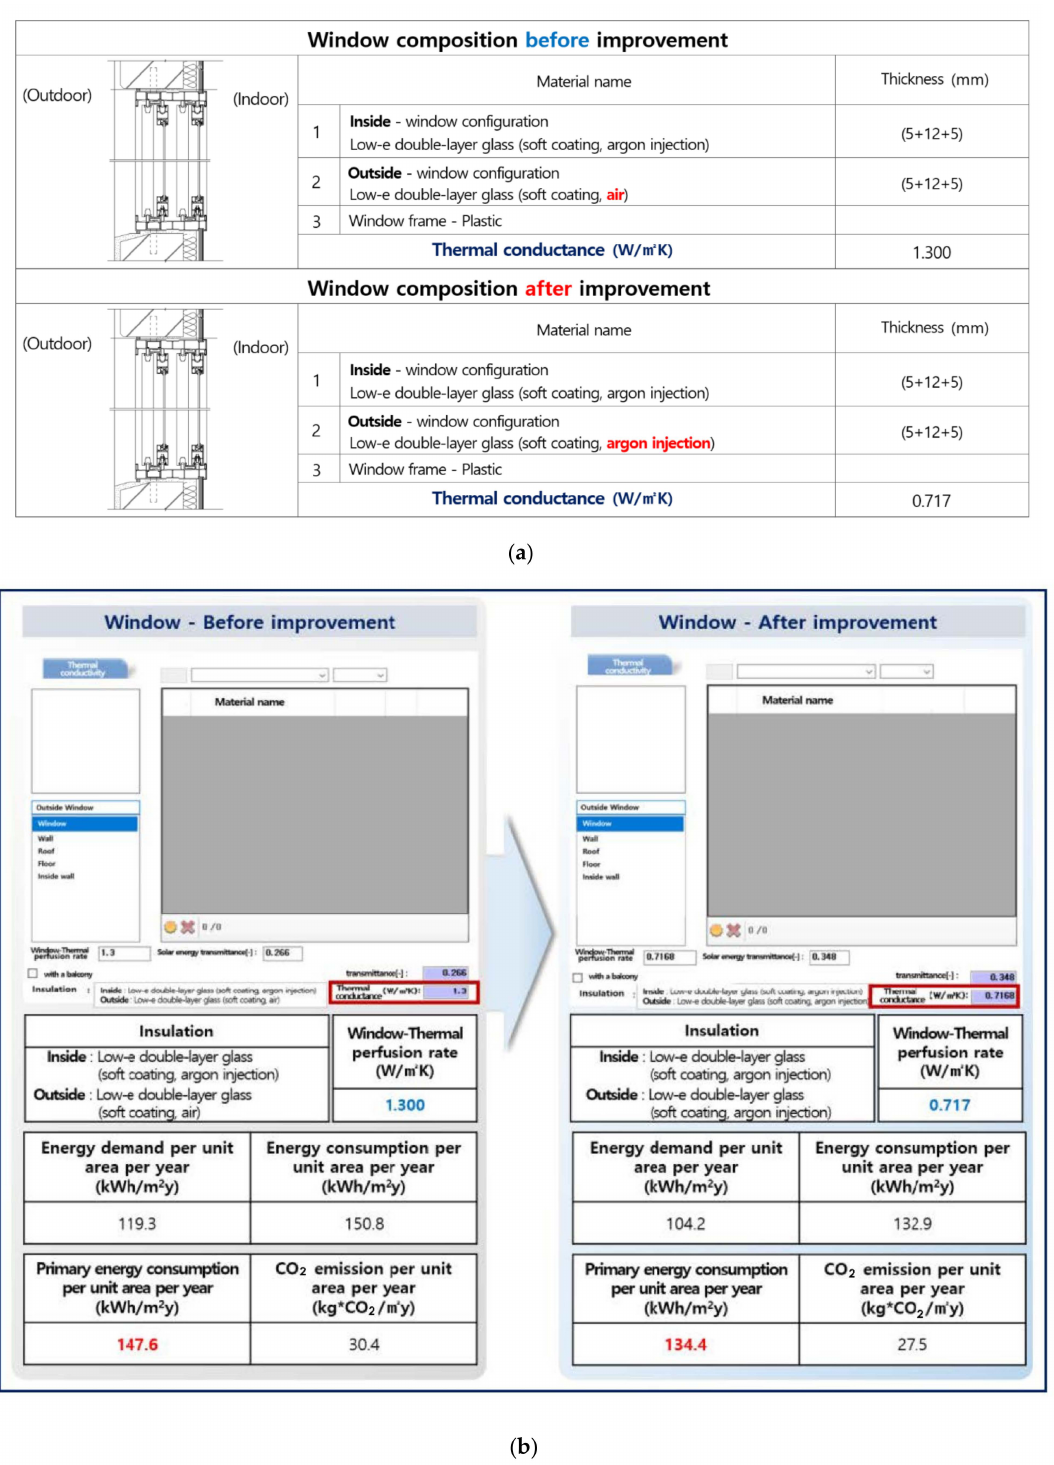
Figure 8. ( a ) Window composition before and after improvement in M MDU; ( b ) Window input and simulation calculation results before and after ECO2 simulation window improvement in M